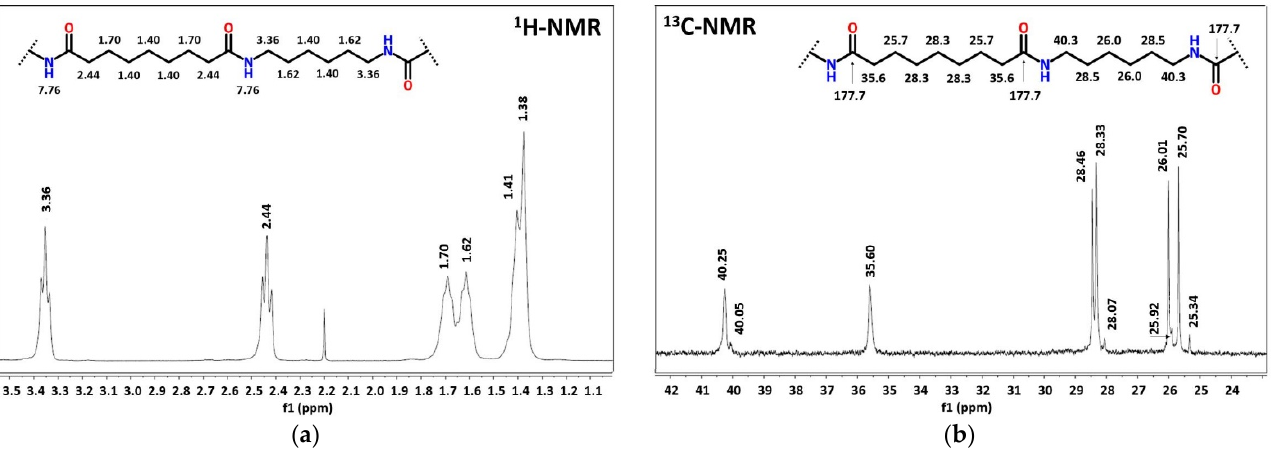
( b ) Figure 3. DSC curves of PA6.9-6 60-40 with indication of melting and glass transition temperatures ( a ), melting temperatures for different monomers ratio ( b ). The melting temperature is decreasing with the increase in AAH salt component, up to a value of 135 °C when the PA6.9 and PA6 content are 50–50% in weight (Figure 2b). This melting temperature agrees with the value obtained blending and keeping the two polymers at 288 °C after 13 h. In that case, it was stated that the material obtained was a